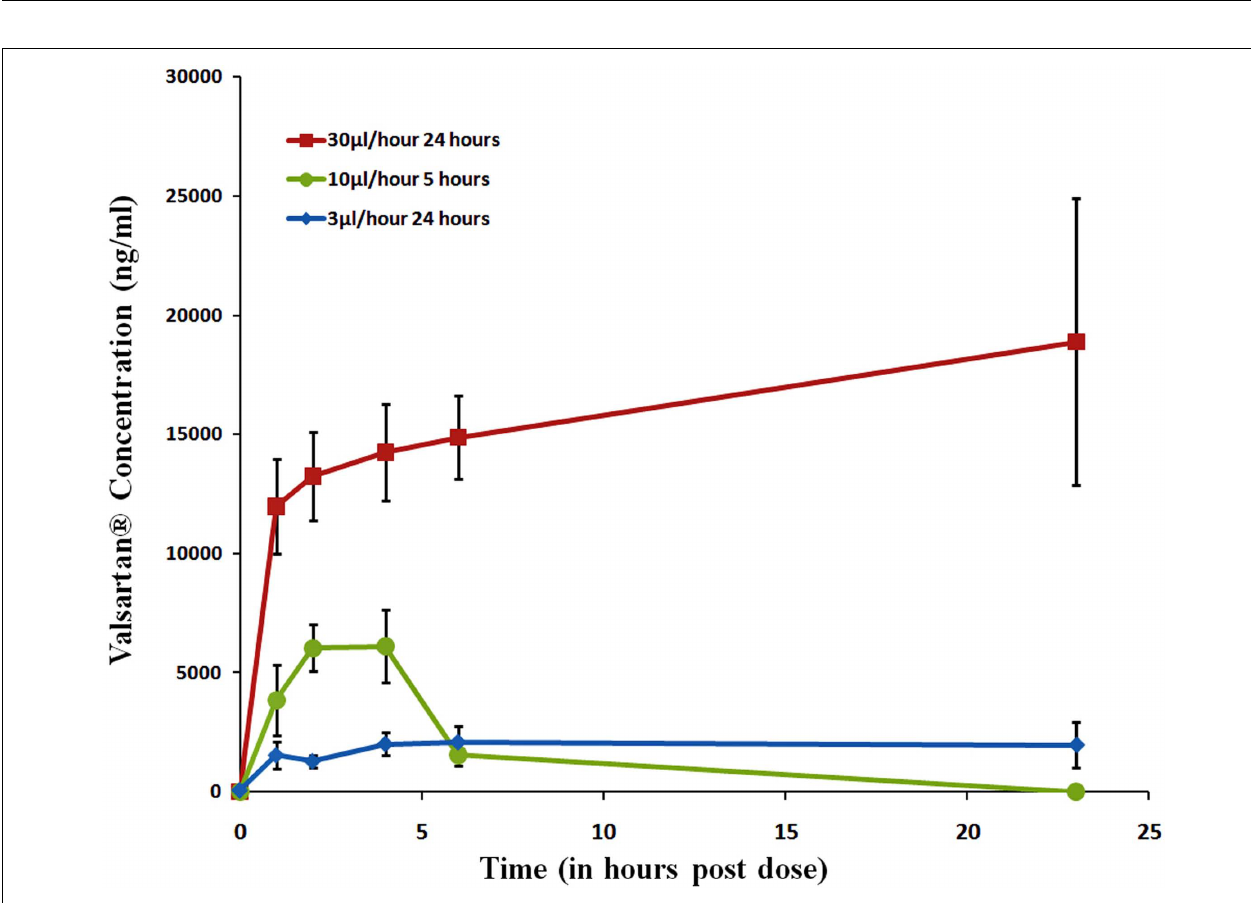
FIGURE 10 | Brief description of study protocol forValsartan ® infusion and blood sampling. More detailed descriptions are shown in Tables 4 and 5 .